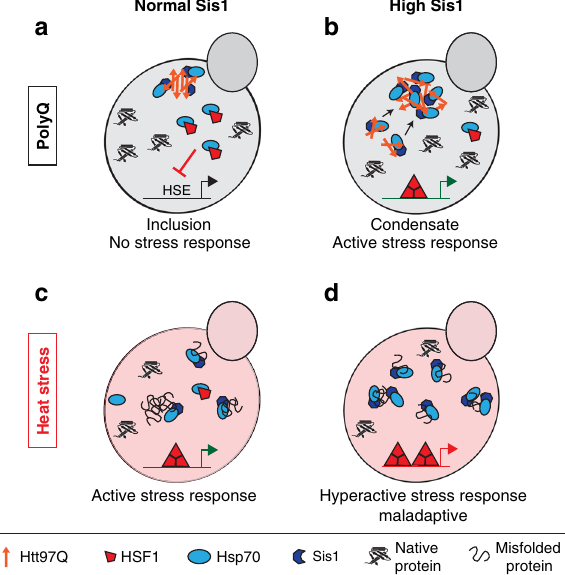
Fig. 7 Hypothetical model for Sis1 function in regulating the stress response. a Normal Sis1 levels. Htt97Q aggregates form dense inclusions that are inaccessible to Hsp70. HSF1 remains Hsp70-bound and inactive. HSE, heat shock element in the promoter. b Elevated Sis1 interacts with soluble polyQ oligomers and mediates their coalescence into cloud-like condensates that are permeable to Hsp70. As a result, Hsp70 is titrated away from HSF1, activating the HSR. Active HSF1 is shown as a trimer. c Normal Sis1 levels. During heat stress, Sis1 recruits Hsp70 to conformationally destabilized (misfolded) protein species. As a result, Hsp70 is titrated away from HSF1, activating the HSR. d Elevated Sis1 levels recruit an increased amount of Hsp70 to misfolded proteins during stress, resulting in a hyperactive, maladapted stress